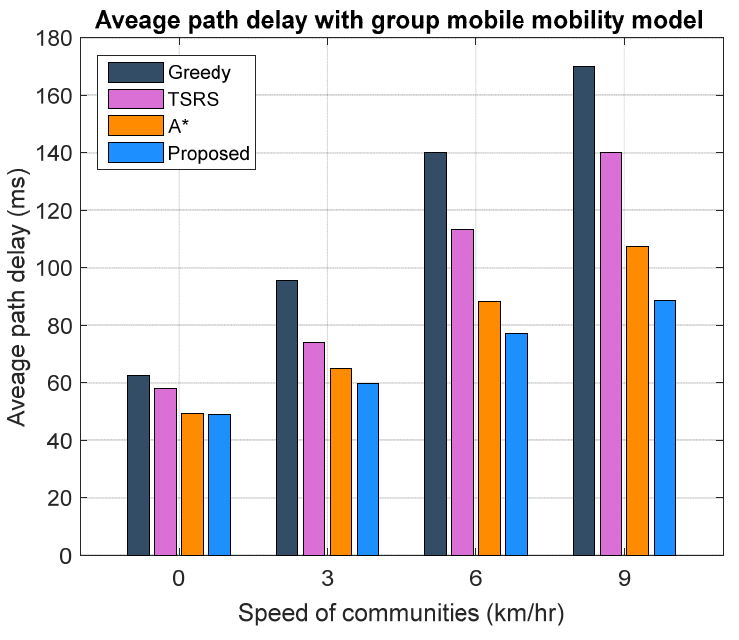
Figure 24. Delay vs. group’s moving speed.